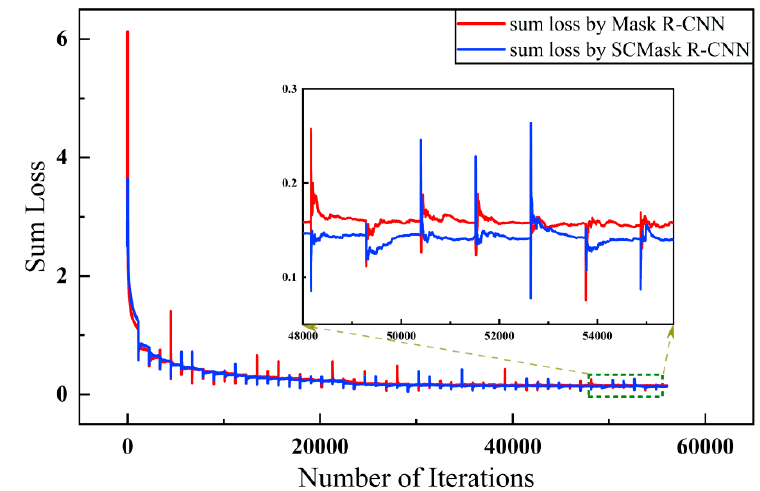
Figure 7. Loss curve. It describes the relationship between the loss and the number of iterations. The training processes of Mask R-CNN and SCMask R-CNN corresponds to the red and the blue curve respectively. We have enlarged the curve in the green box. At the end of training, the blue is lower than the red curve overall, i.e., the loss in our method is smaller.